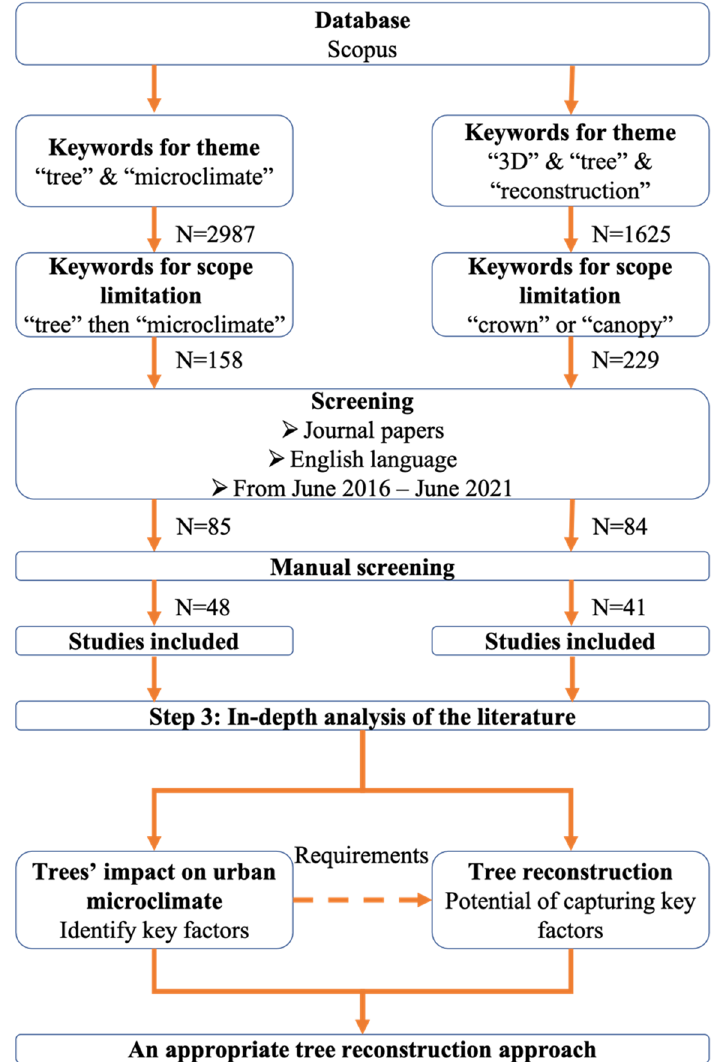
Figure 1. Workflow of the research process.